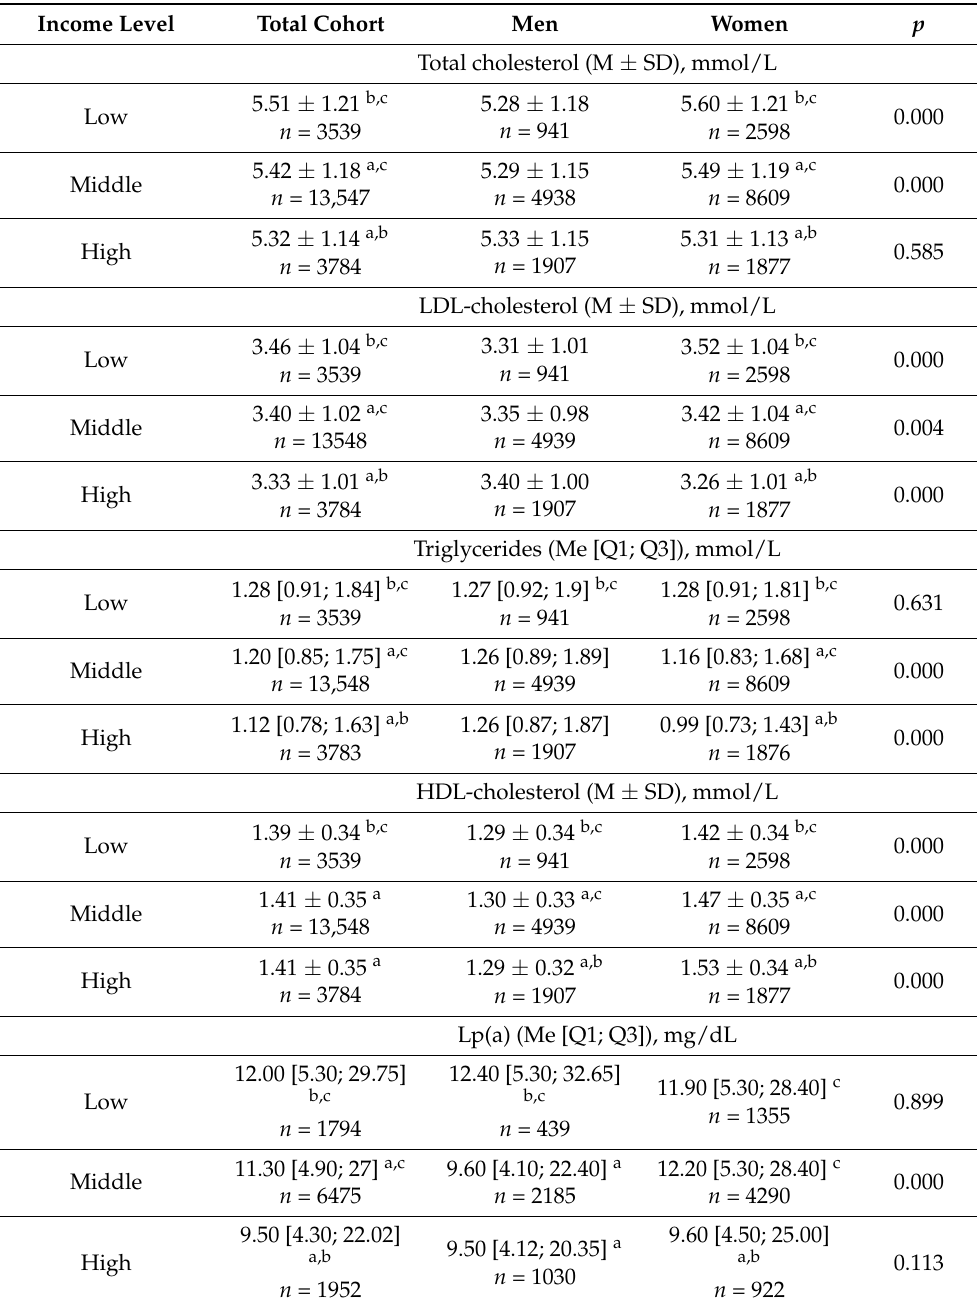
Table 3. Lipoprotein profile parameters in men and women differing in income level among popula- tions from regions of the Russian Federation: ESSE-RF